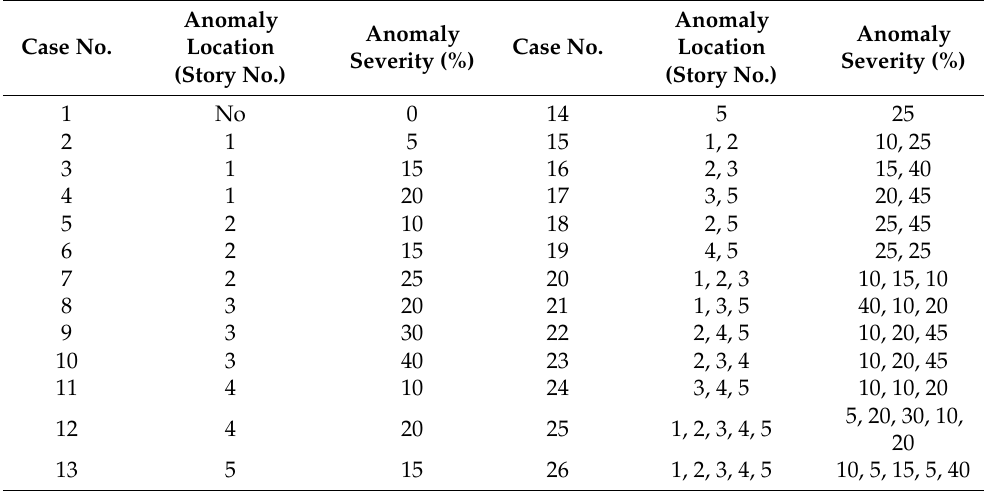
Table 1. Condition scenarios of building anomalies due to stiffness reduction.